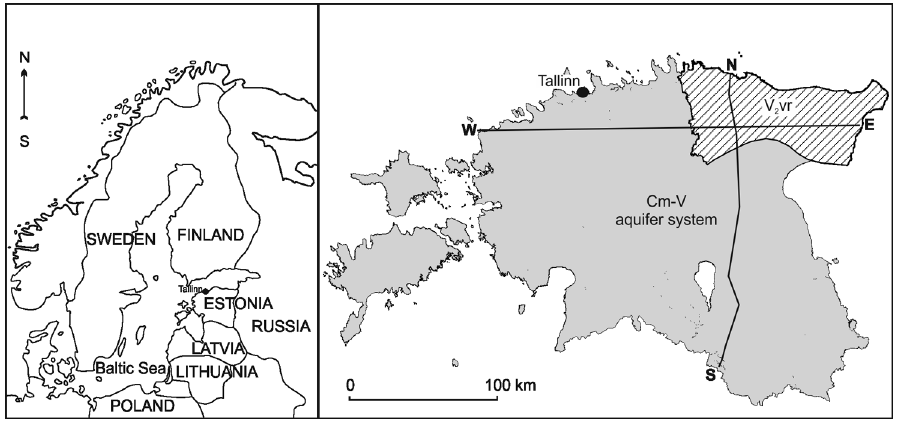
Fig. 1. Schematic map of the study area showing the location of the V 2 vr groundwater body (V 2 vr) and the lines of hydrogeo- logical cross sections.